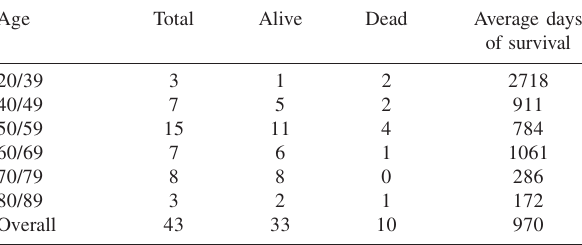
Table 2- Days of survival by age